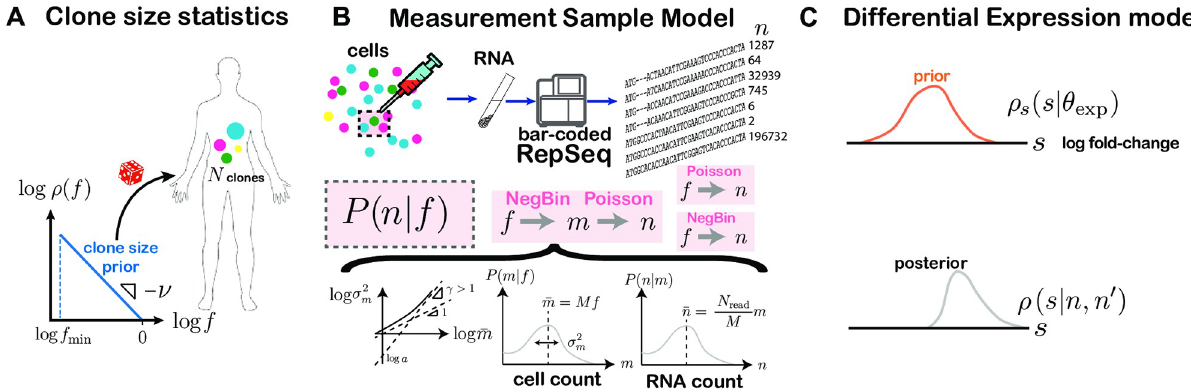
Fig 1. Model components. (A) Clone frequencies are sampled from a prior density of power law form with power ν and minimum frequency, f min . (B) Each clone’s frequency f determines the count distribution, P ( n | f ),that governs its mRNA count statistics in the observed sample. We consider 3 forms for P ( n | f ):Poisson, negative binomial, and a two-step (negative binomial to Poisson) model. The negative binomial and two-step measurement models are parametrized through a mean-variance relationship specifying the power, γ , and coefficient, a , of the over-dispersion of cell count statistics. The mean cell count scales with the number of cells in the sample, M , while the mean read count scales with with the number of cells, m , and the sampling efficiency, M / N read , with N read the measured number of molecules in the sample. The parameters of the measurement model are learned on pairs of sequenced repertoire replicates. (C) Differential expression is implemented in the model via a random log fold change, s , distributed according to the prior ρ ( s | θ exp ). The prior’s parameters, θ exp , are learned from the dataset using maximum likelihood. Once learned, the model is used to compute posteriors over s given observed count pairs, which is used to make inferences about specific